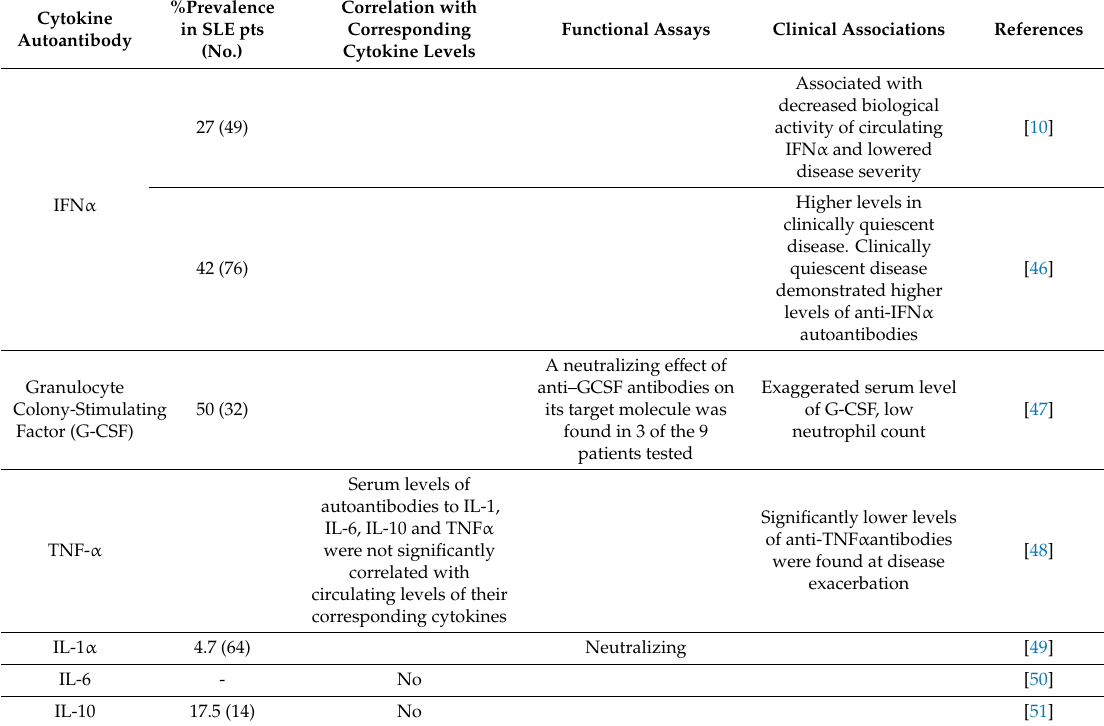
Table 1. Anti-cytokine autoantibodies in systemic lupus erythematosus. Cytokine